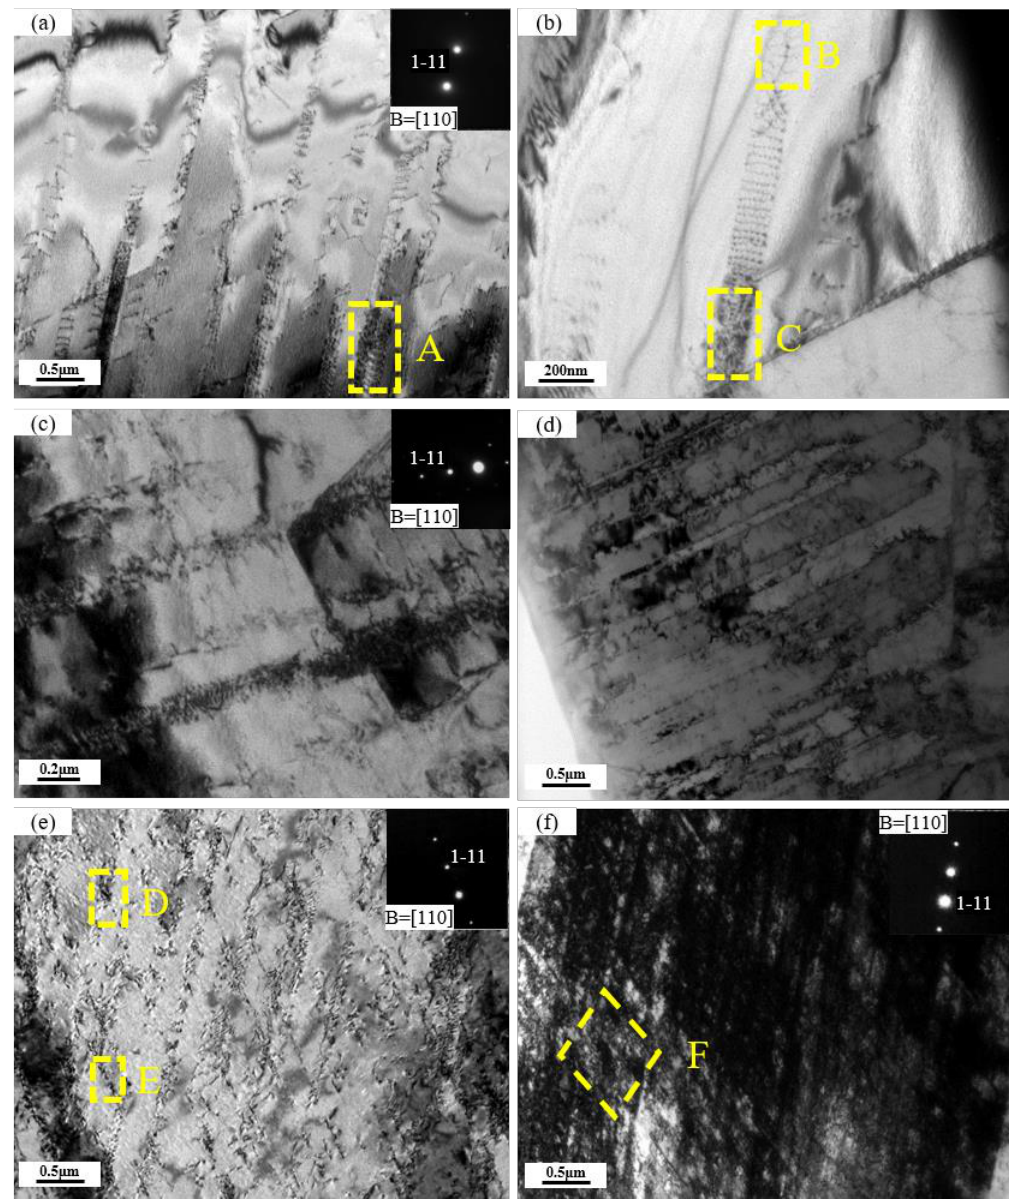
Figure 8. TEM images of different deformation of experimental steel. ( a ) 5%; ( b ) 5%; ( c ) 10%; ( d ) 10%; ( e ) 20%; and ( f ) 50%.